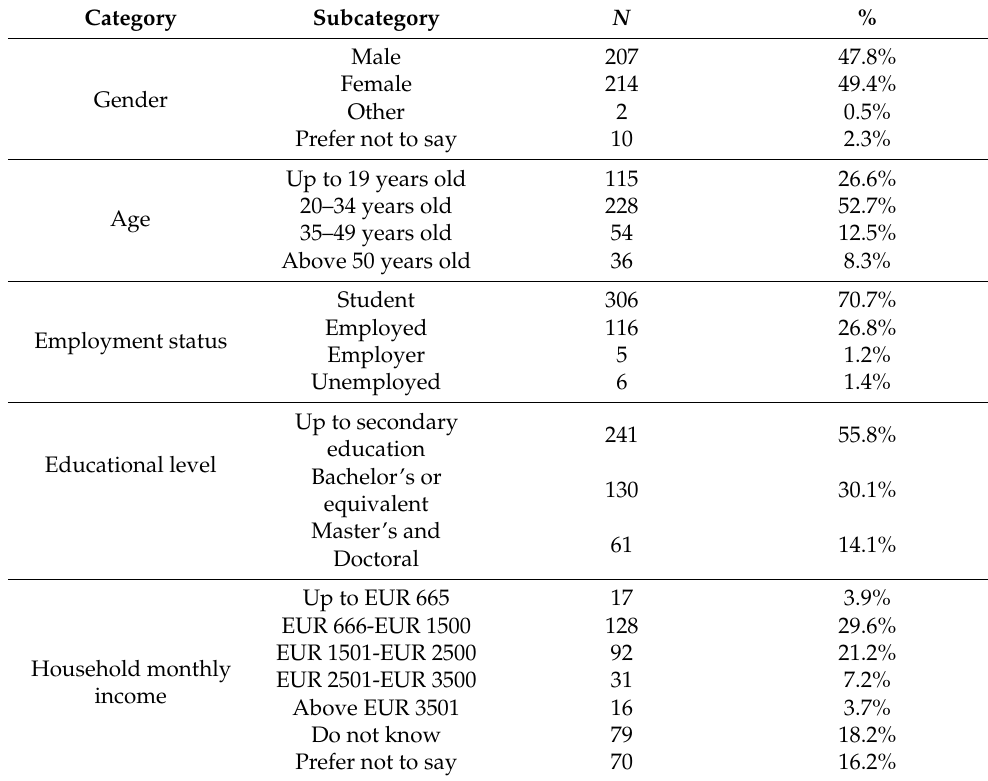
Table 3. Profile of respondents (users and potential users) in